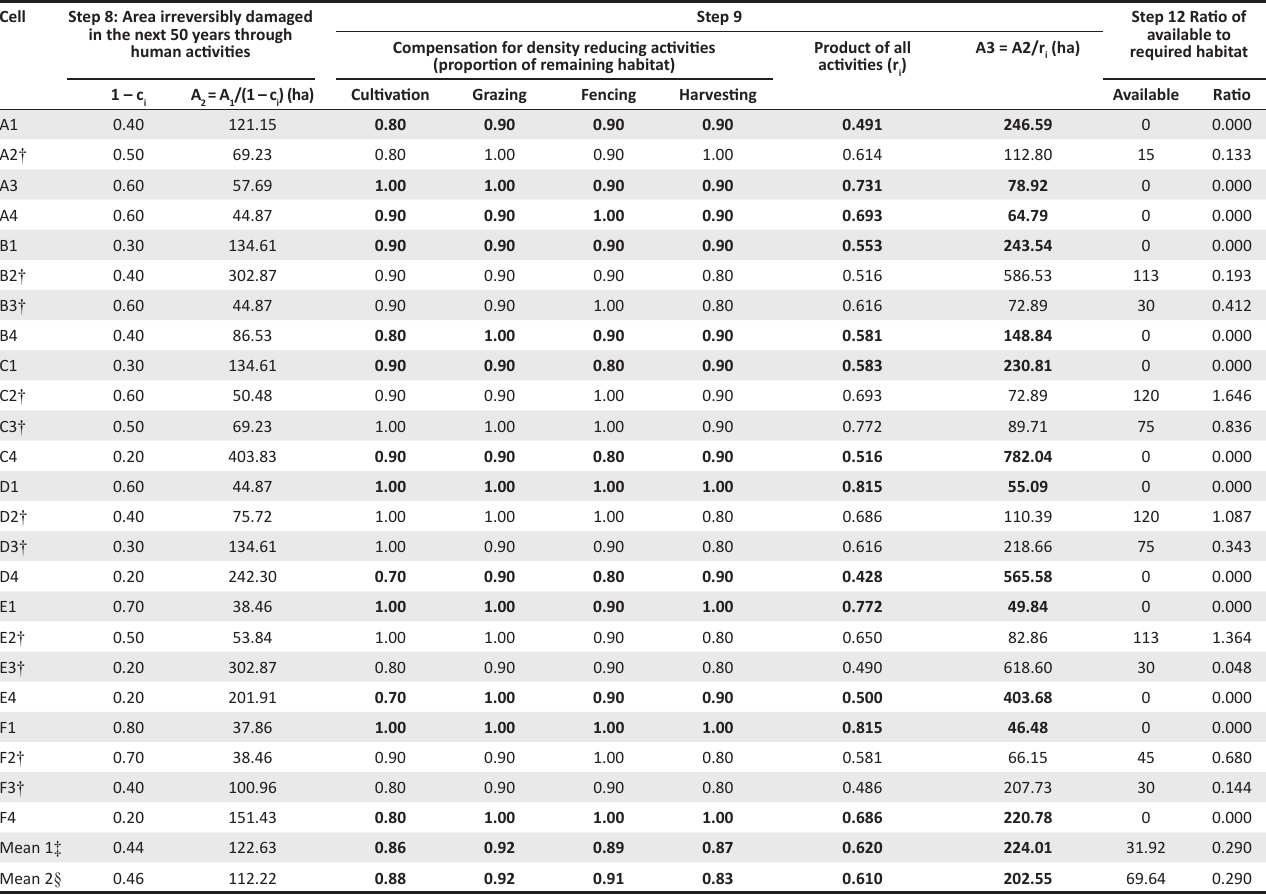
TABLE 2d: Brackenridge zanguebarica minimum conservation area size using Burgman et al. ’ s method (Steps 8, 9 and 12): Scenario 3 – Reduction in human-related activities.